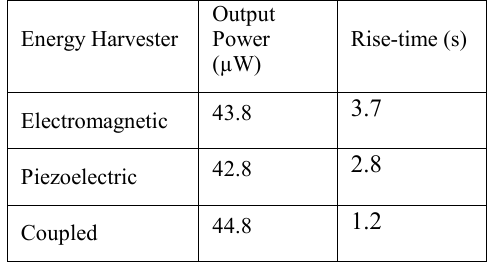
Figure 9: Plot comparing the rise time to charge a 22µF capacitor using different combinations of piezoelectric diaphragms